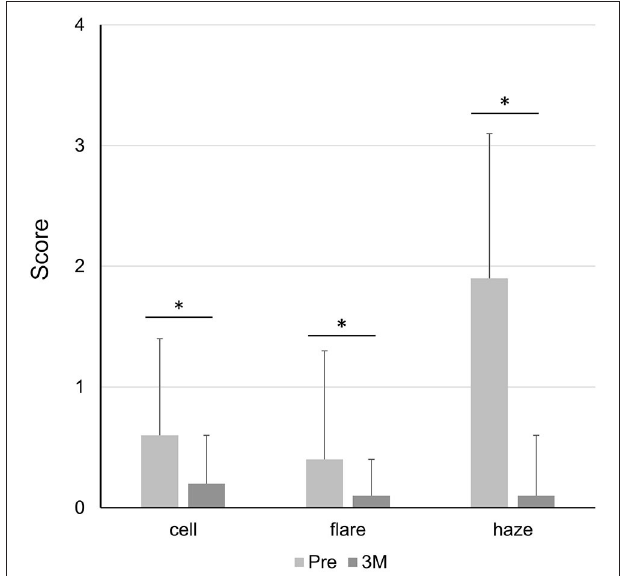
TABLE 2 | Surgical